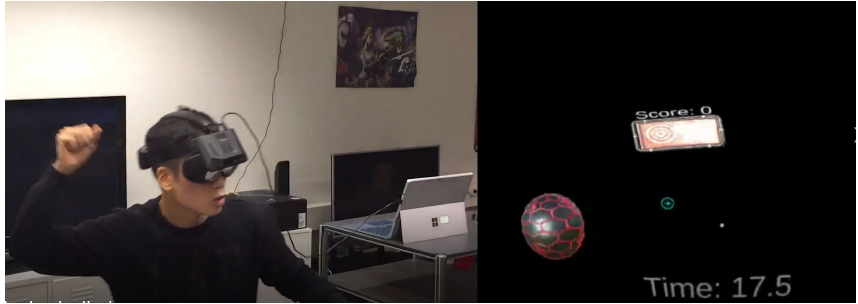
Figure 1. VR dodgeball game implementing ExerSense